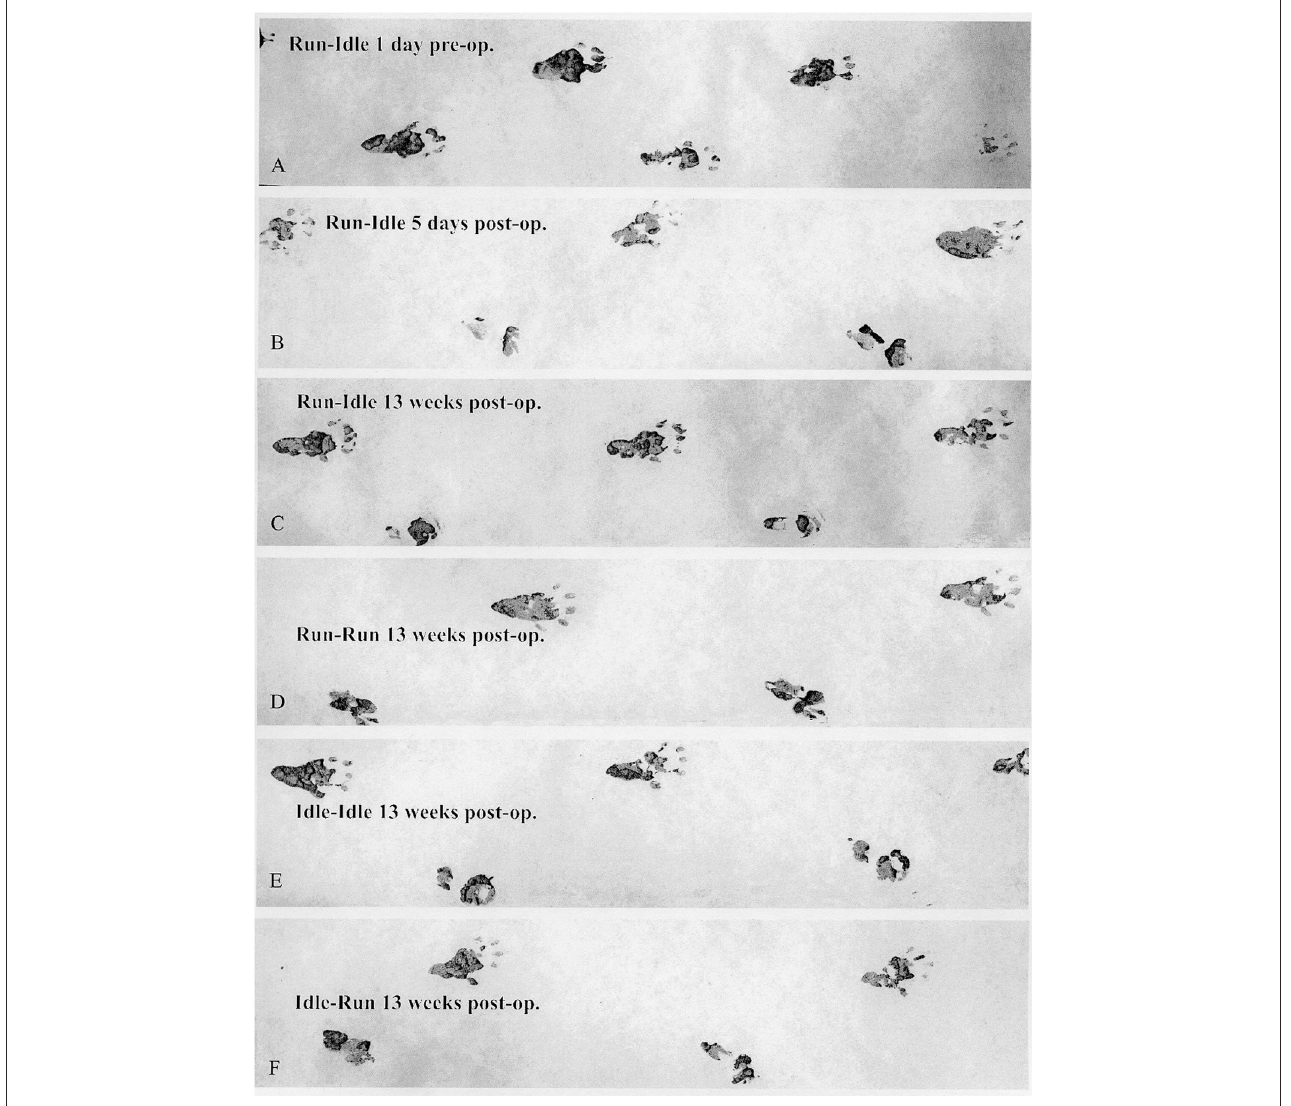
FIGURE2 Walking track analysis. Representative sets of footprints running from left to right. (A) This track was made by a trained normal rat (run–idle 1 day before nerve transplant), with a symmetrical gait and well-splayed toes. (B) The second track presents the completely paralyzed right (operated) hind paw 5 days after the sciatic nerve transplant. The four lowest tracks (C–F) were recorded 13 weeks after sciatic nerve surgery. The upper prints from the second to the last track stem are from the intact left hind paw, and the lower are prints from the misdirectly reinnervated right hind paw. A comparison of the run–idle tracks at 5 and 91 days after nerve transplantation shows no improvement in the motor control of the right foot and the gait pattern. For details on the measurement of footprints, see Supplementary Figure